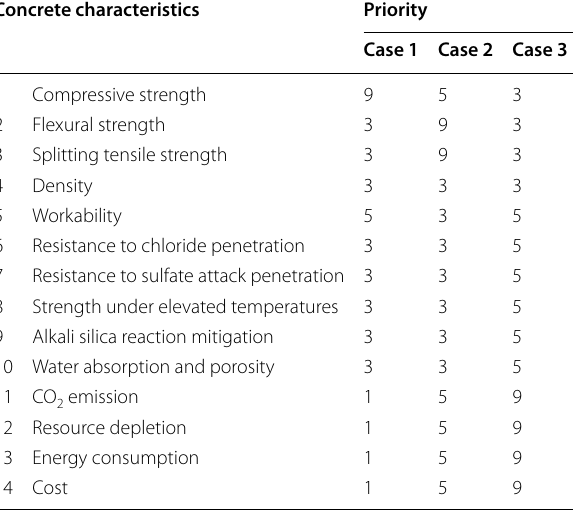
Table 4 Priority of each